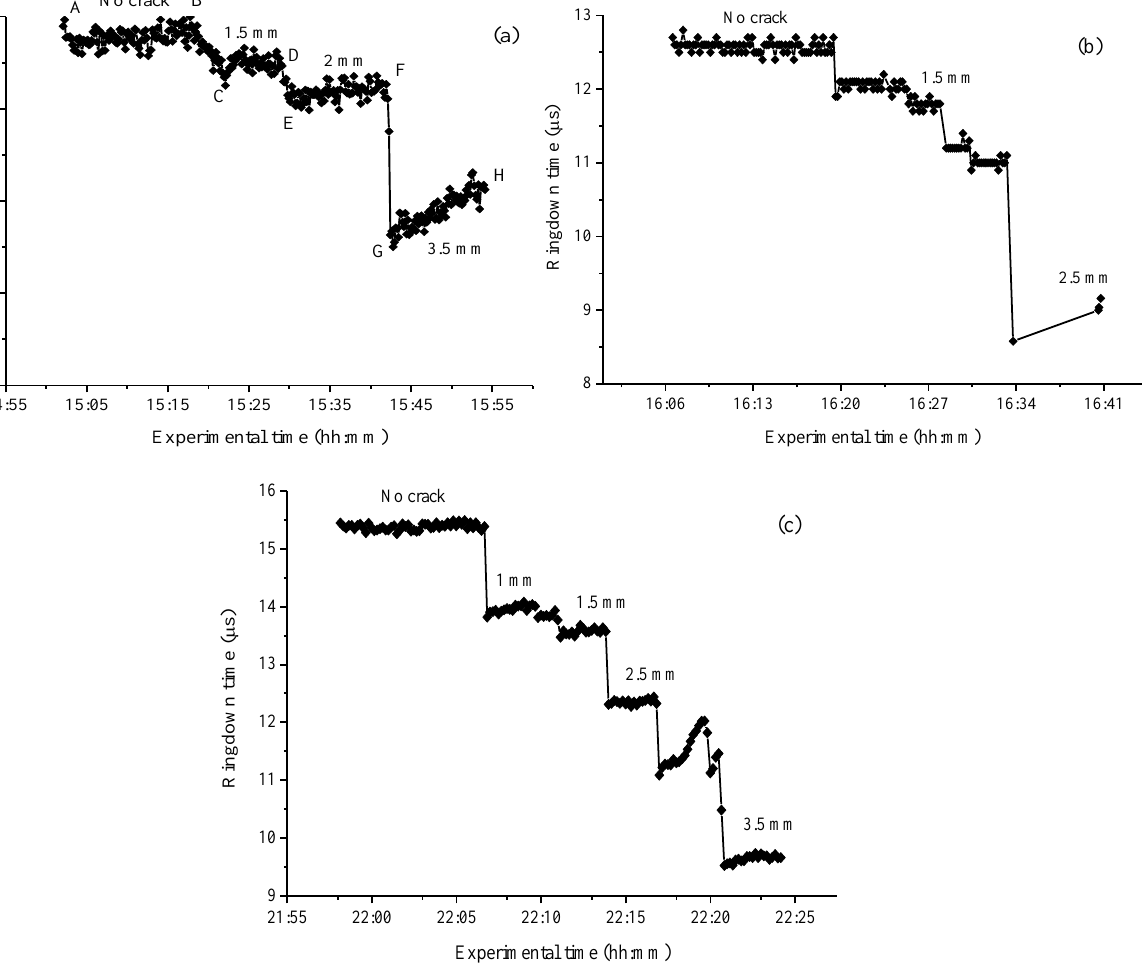
Figure 5. Responses of FLRD crack sensors to different surface crack widths; Figure 5( a – c ), are the responses of units-1 , 2 , and 3 ,